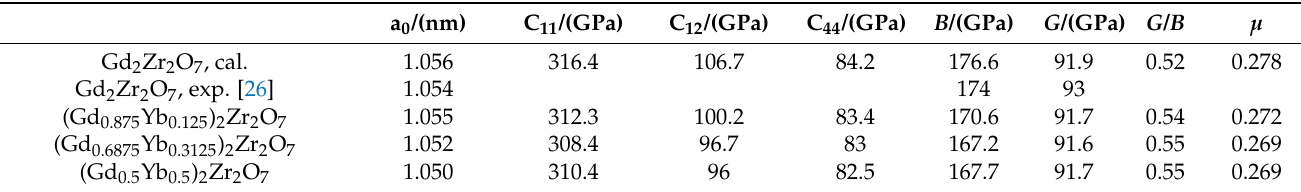
Table 1. Lattice constant, the elastic constants (C 11 , C 12 , and C 44 ), bulk modulus ( B ), shear modulus ( G ), and Poisson’s ratio ( µ ) of rare earth zirconates. a 0 /(nm) C 11 /(GPa) C 12 /(GPa) C 44 /(GPa) Gd 2 Zr 2 O 7 ,